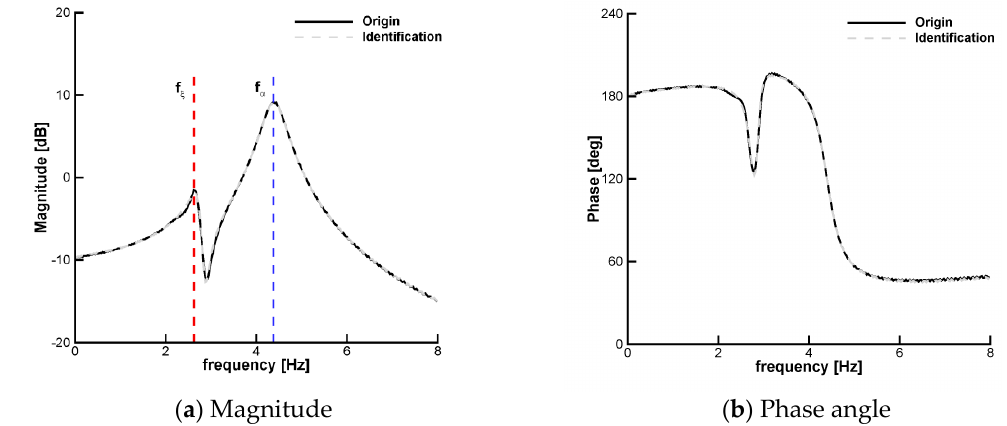
Figure 9. Bode plots of system time-response to a chirp input and the identified transfer function; “Origin” indicates the original model to be identified.